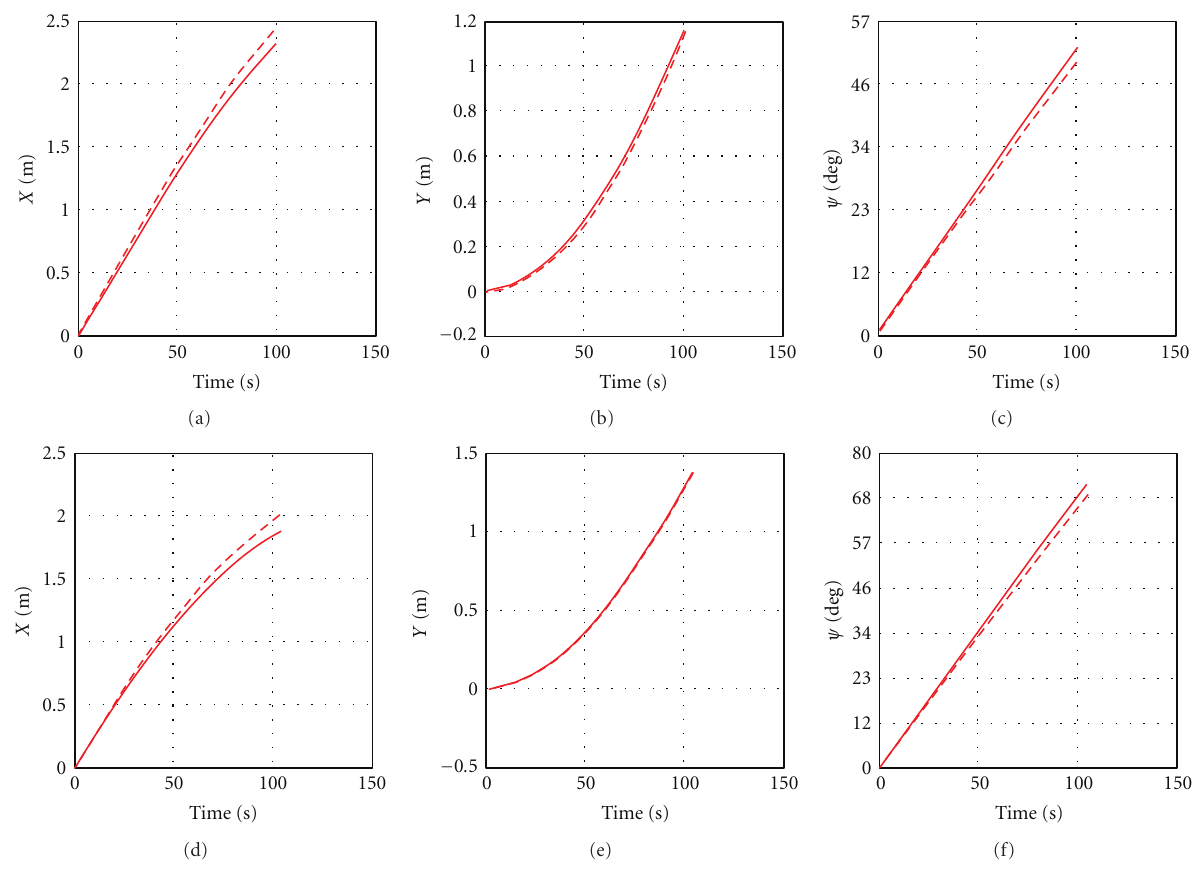
Figure 3: Experiment (dashed line) and simulation (solid line) correlation in two steering maneuvers: test 1 (top) and test 2 (bottom).